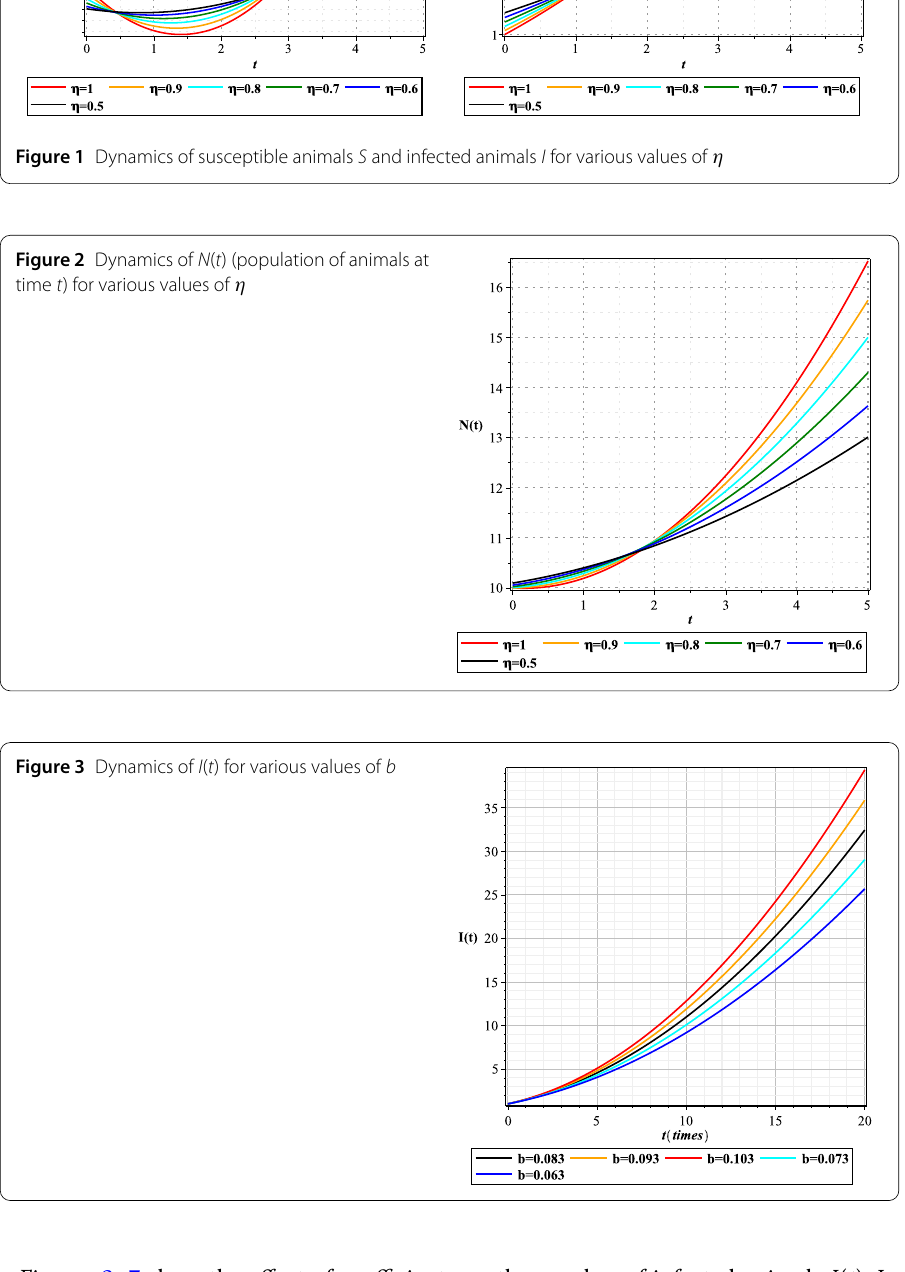
Figures 3–7 show the effect of coefficients on the number of infected animals I ( t ). In Fig. 3, we plotted I ( t ) for different values of b , and we see that increasing b increases